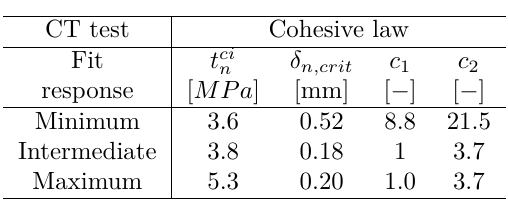
Table 2. Values of the cohesive law parameters for the crack along the grain calibrated to the results of inverse analysis for the minimum, intermediate, and maximum response of the CT test results (transcribed from